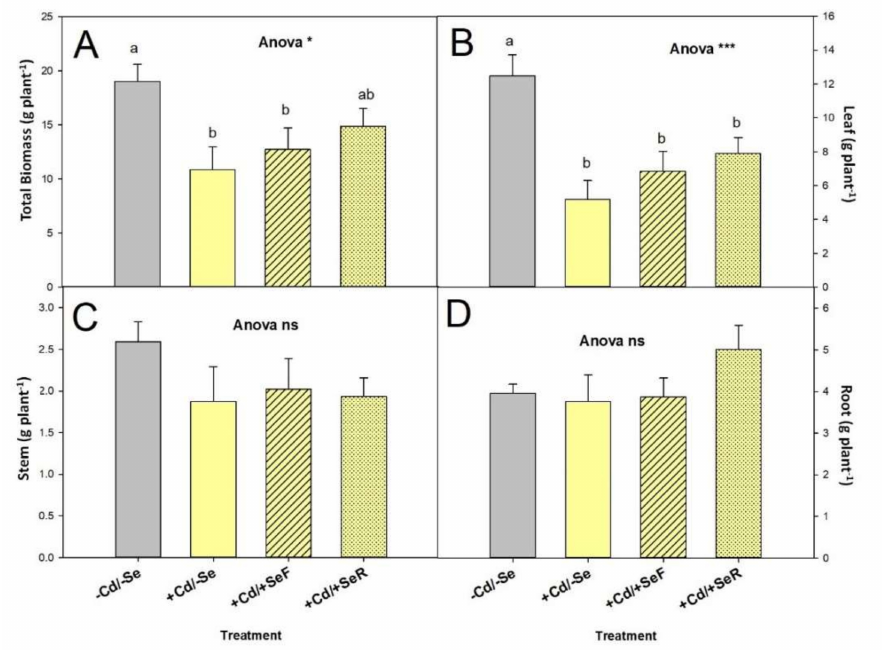
Figure 1. Total biomass (g DW; ( A )), leaf (g DW; ( B )), stem (g DW; ( C )) and root (g DW; ( D )) of pepper plants under four treatments of cadmium and selenium ( − Cd/ − Se, +Cd/ − Se; +Cd/+SeF and +Cd/+SeR). In the ANOVA, * and *** indicate significant differences for p < 0.05 and 0.0001. The different lowercase letters indicate significant differences between the treatments for p < 0.05 established by Tukey’s multiple range test. The vertical bar indicates the standard error of the